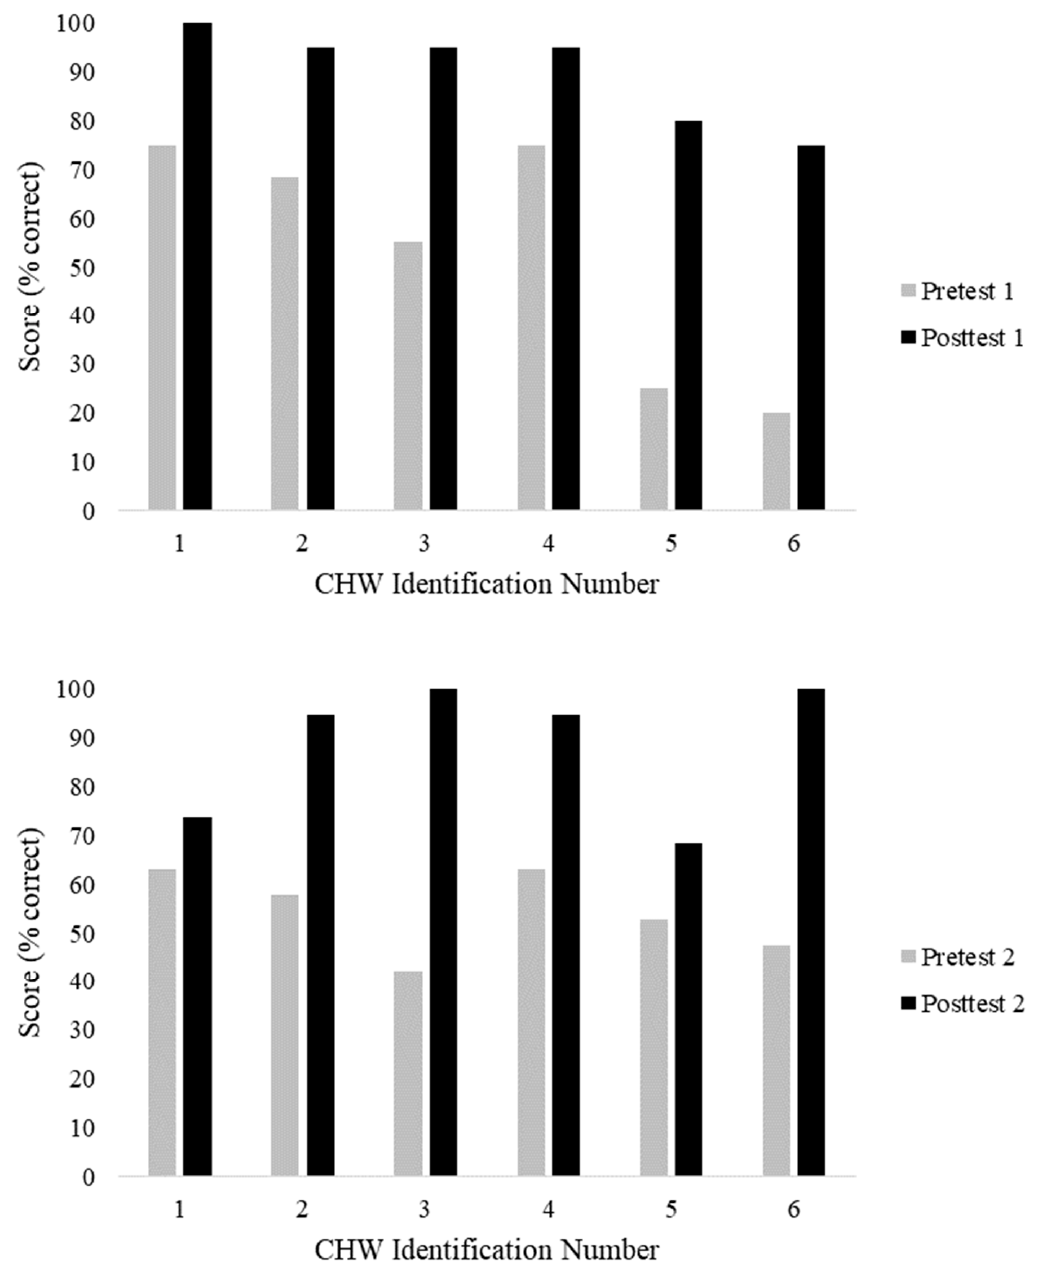
Figure 1. ( Top ) ( p = 0.002) and TEST-2 ( Bottom ) ( p = 0.0019). CHW: Community Health Worker The results of the 12-month mHealth data are summarized in Table 3. There was strong evidence of CHWs applying their training in their work. A total of 984 incidences were recorded. The highest number of barriers were at the patient-level (n = 610), followed by the healthcare system (n = 223), and provider (n = 151). Of the patient-level barriers, glucose level education was the most common (n = 367) followed by adherence strategies (n = 195). Of the provider-level barriers, medication identification, use, and instructions occurred the most (n = 93), and of the healthcare system, obtaining refills and correct amounts from the pharmacy was most frequent (n =